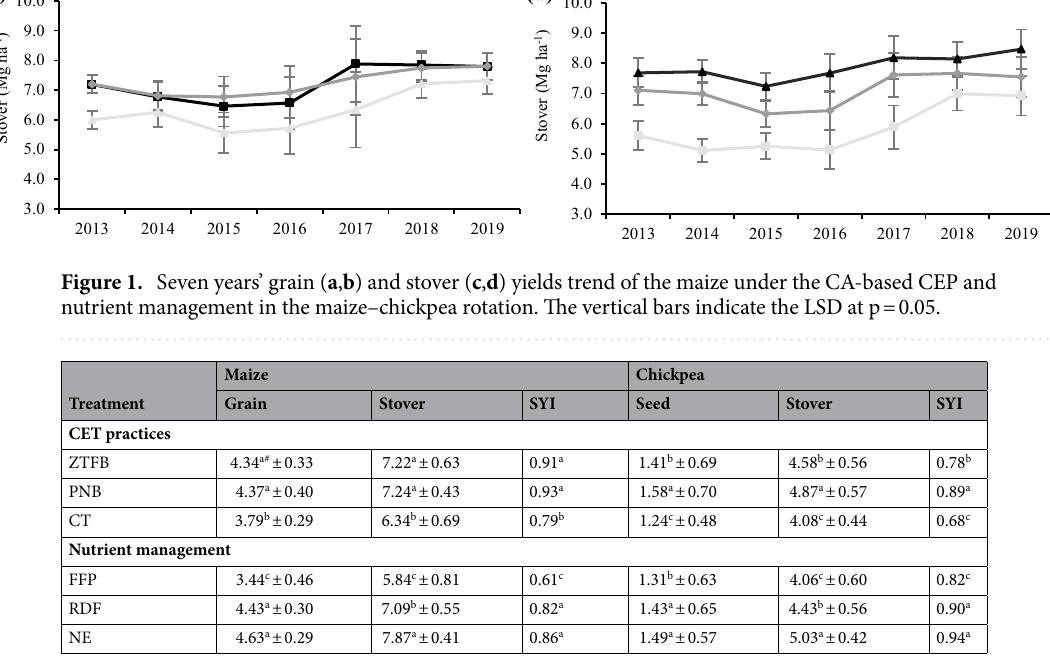
Table 1. Seven years’ mean grain/seed and stover yields (Mg ha −1 ) (± S.D.) and sustainable yield index (SYI) under the CA-based CEP and nutrient management in the maize–chickpea rotation. # Means followed by a similar uppercase letter within a column is not significantly different (p < 0.05) according to Tukey’s HSD test.